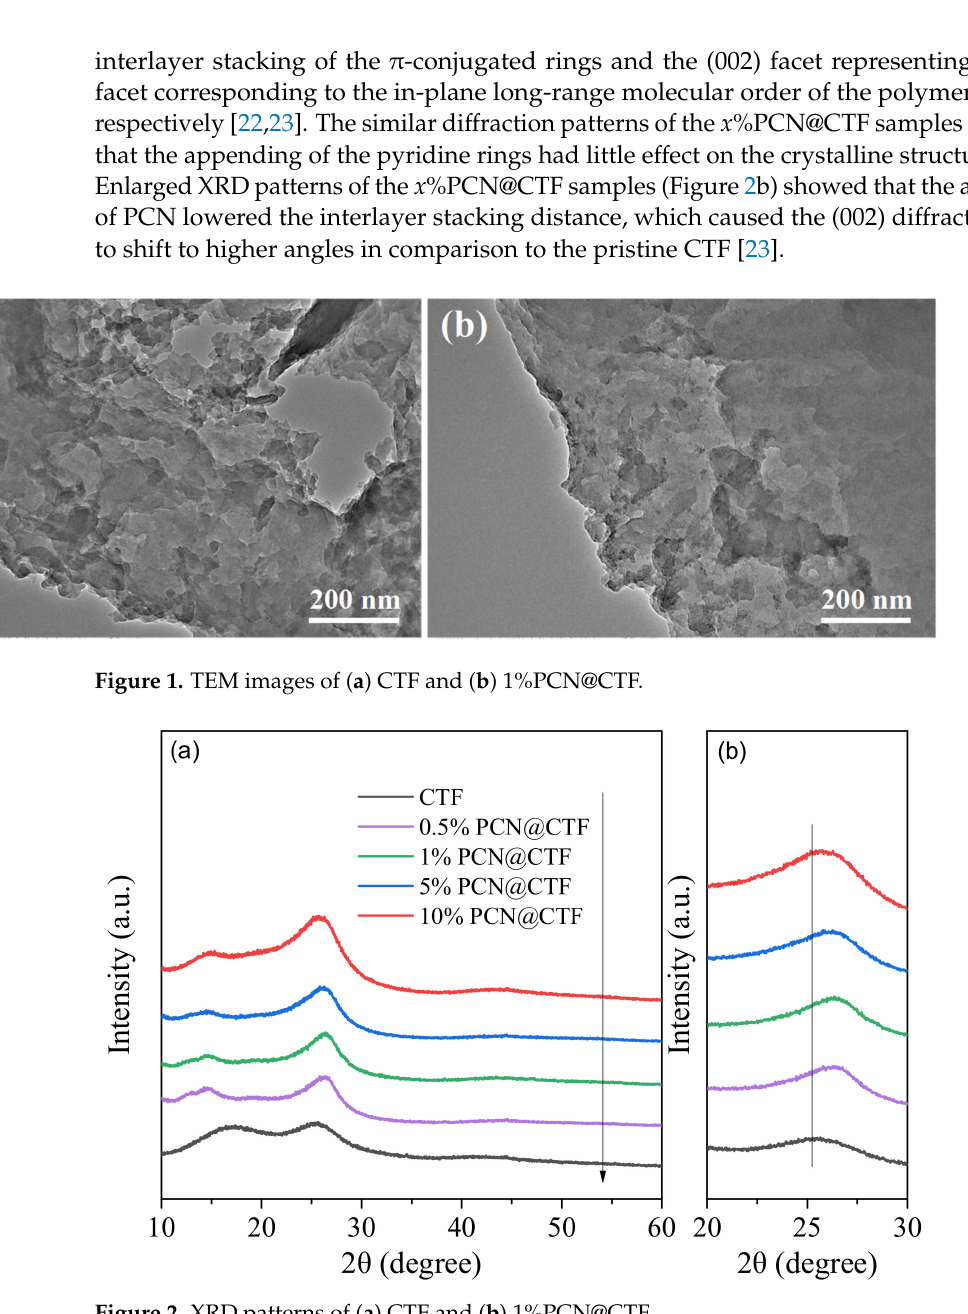
Figure 2. XRD patterns of ( a ) CTF and ( b )